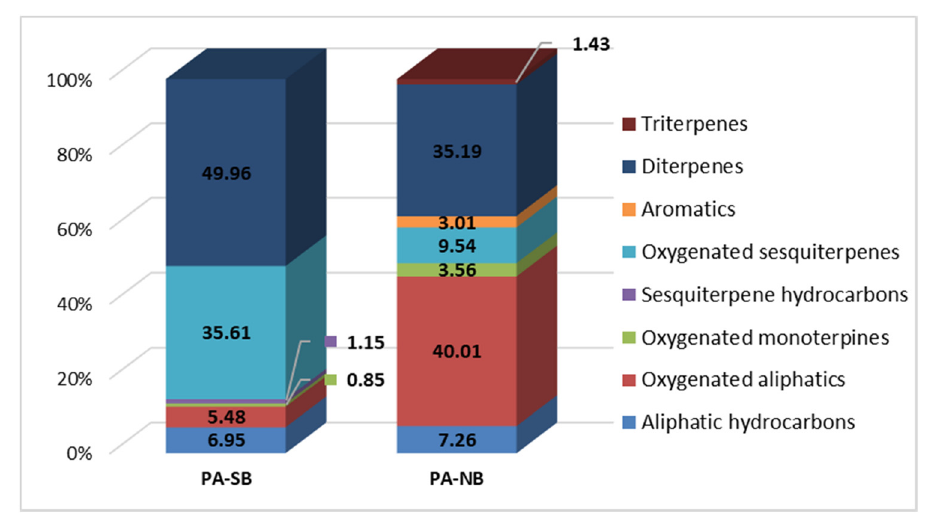
Figure 3: Distribution of compounds ( GC - MS ) in concretes from P. alkekengi leaves: PA - SB – phenotype from Central Southern Bulgaria; PA - NB – phenotype from North - Eastern